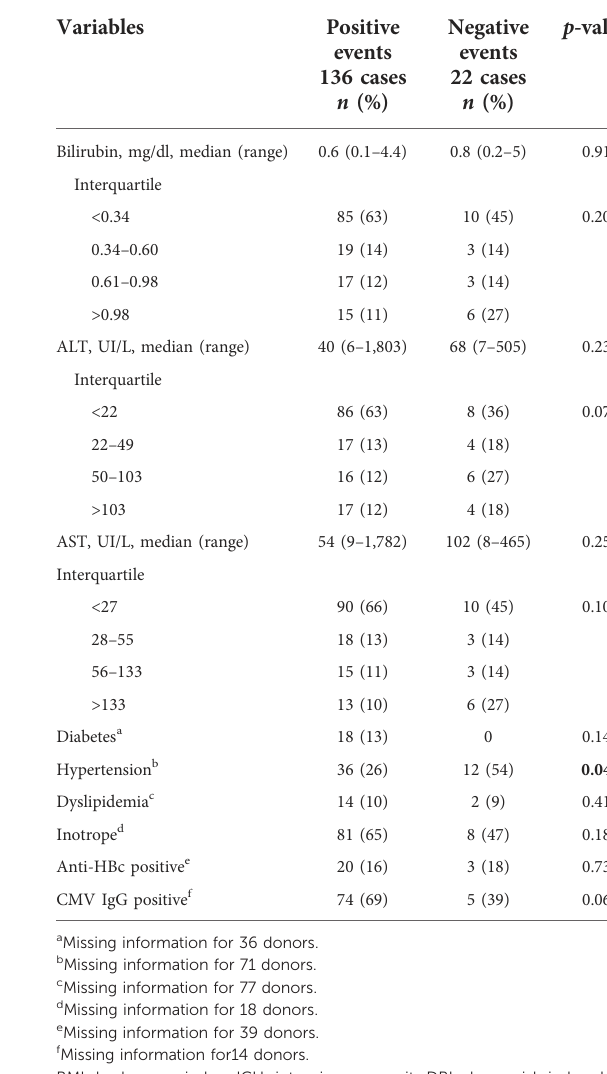
TABLE 1 Univariate analysis of donor characteristics for the negative